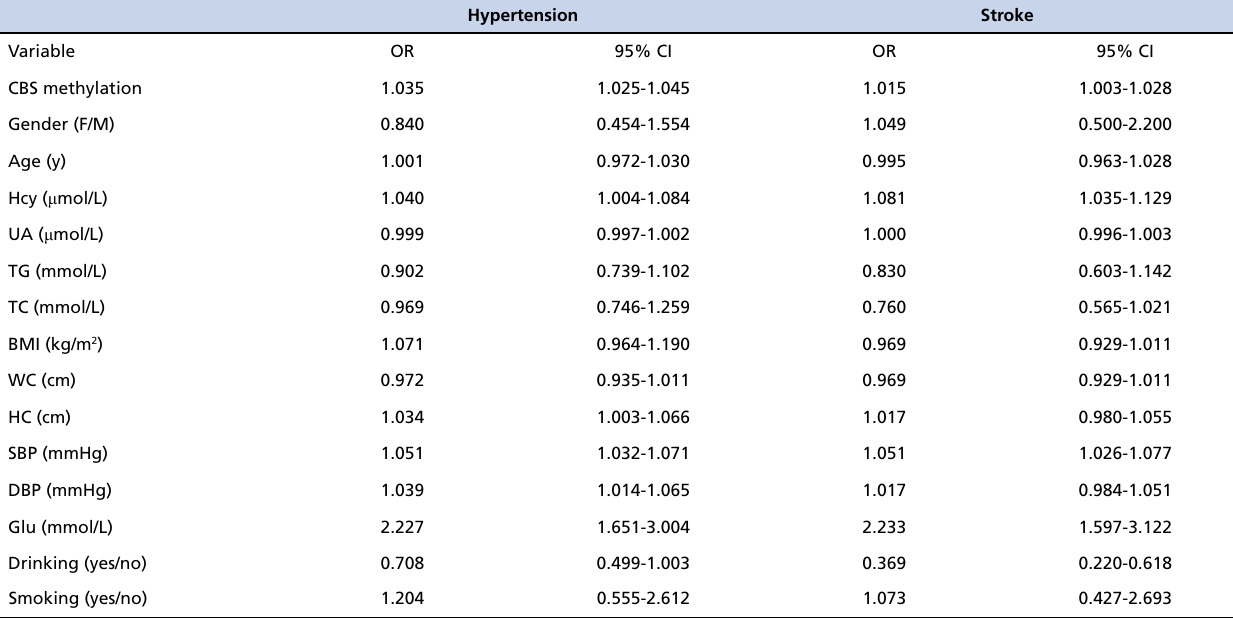
Table 2 - Association of CBS methylation and the risk of hypertension and stroke adjusted by multivariable logistic regression